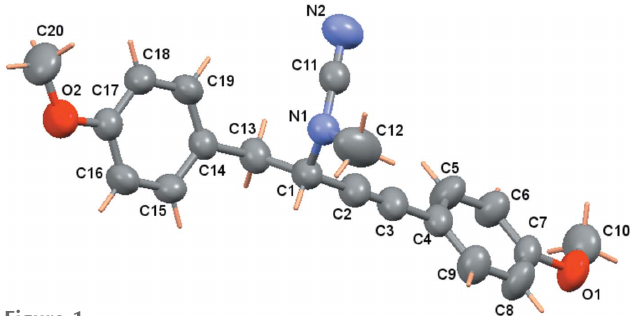
Figure 1 Plot of the title compound with displacement ellipsoids drawn at the 50% probability level. Only the major component of the disorder is shown.